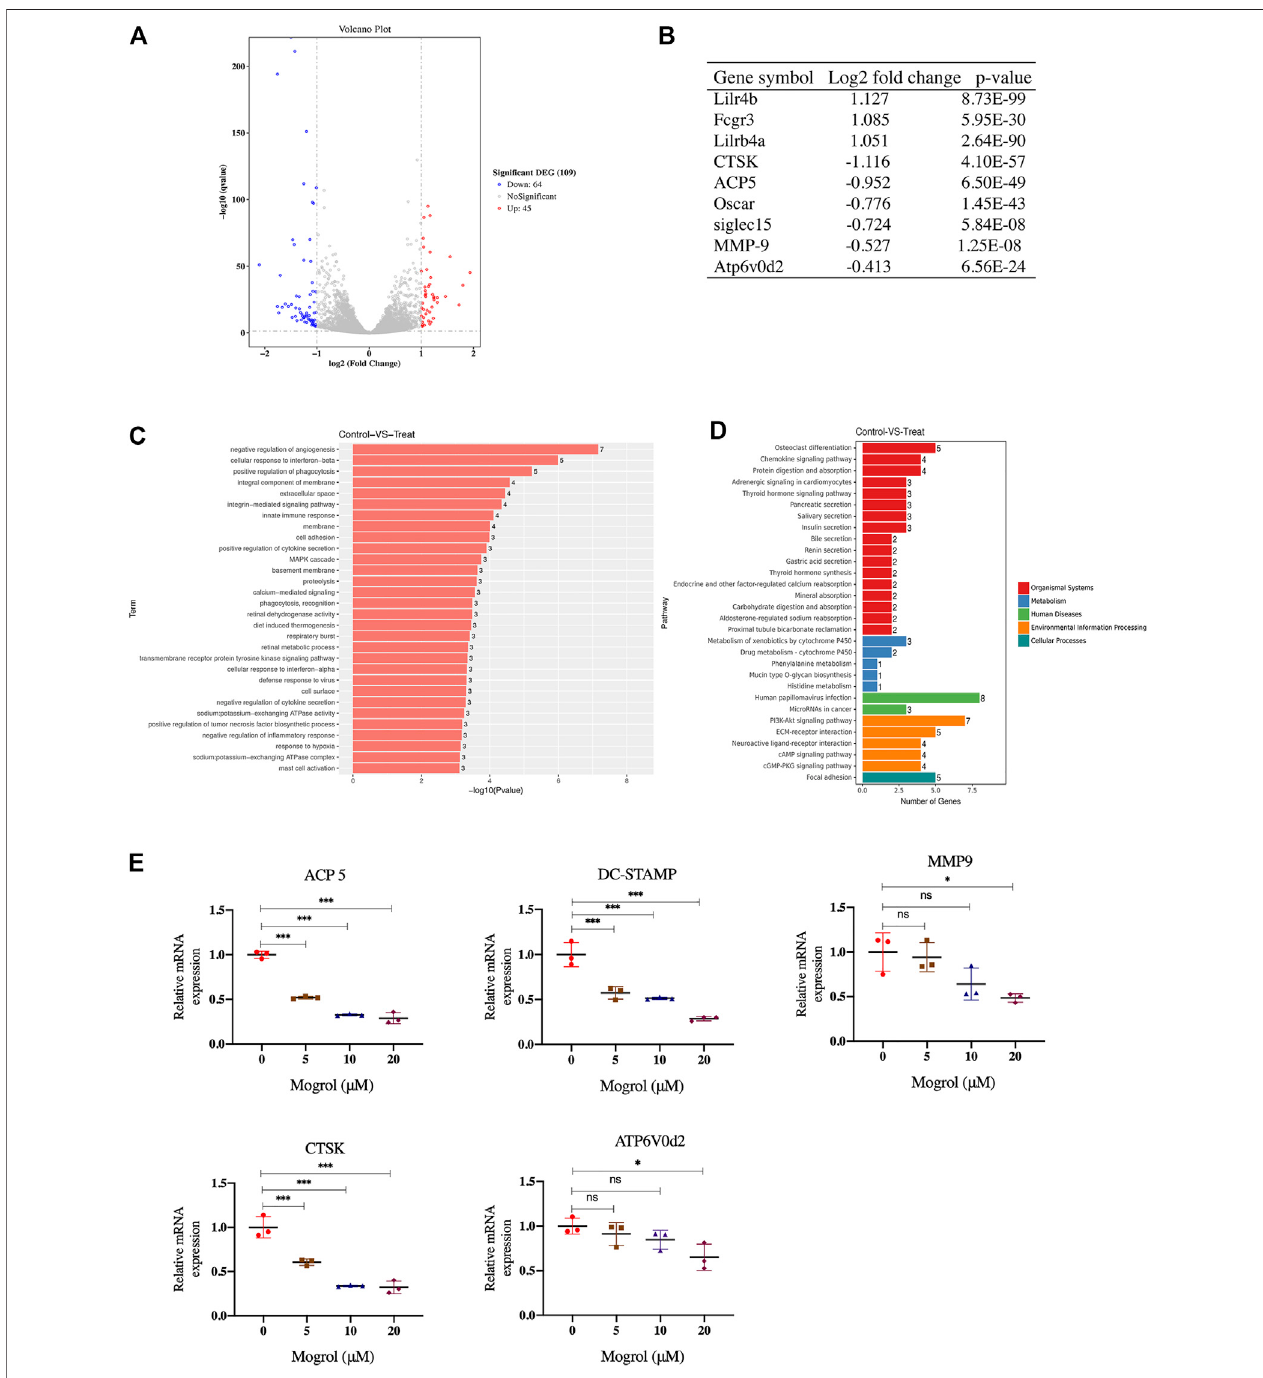
FIGURE 4 | RNA-seq analysis and osteoclast marker gene expression examined by RT – PCR. Identi fi cation of genes that are regulated by mogrol. RNA was extracted from BMMs cultured with or without mogrol treatment for 5 days under RANKL stimulation. (A) Volcano plots of RNA-seq data in mogrol-treated BMMs comparedtocontrolBMMs. (B) Thelog2-foldchangeand p valueofsomeosteoclastogenesis-relatedgenes. (C,D) GeneOntology. (C) GOtermsaredisplayedbygene p values. (D) KEGGpathwaysinthedifferentiallyexpressedgenesareillustratedbygenenumbers. (E) Mogrolinhibitsosteoclastogenesismarkergeneexpression. The expression levels of ACP5, DC-STAMP, MMP9, CTSK and ATP6V0d2 were measured using RT – PCR.